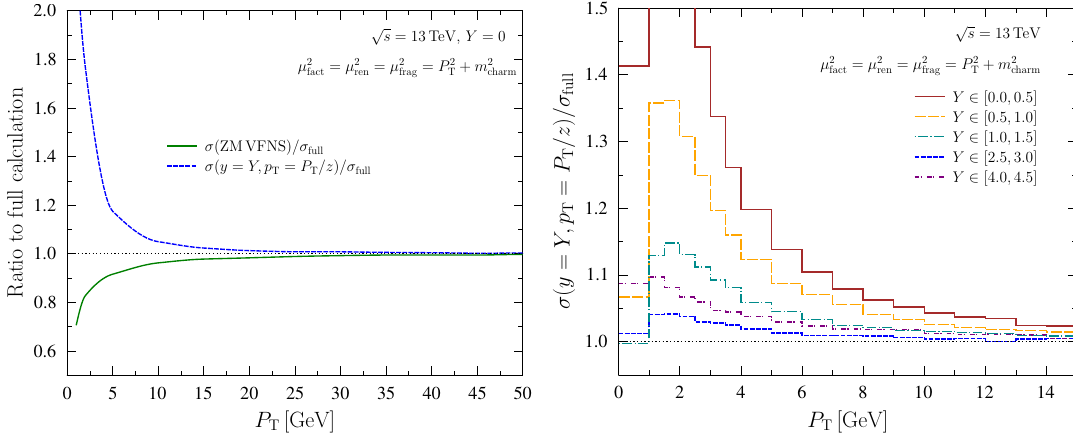
Figure 3 . Left-hand panel: a calculation at Y = 0 taking m = 0 in matrix elements (green curve), and the calculation ignoring the mass dependencies in the fragmentation variable z (blue dashed curve). In both cases, the results are normalized to the full calculation. Right-hand panel: relative e(cid:11)ect also at Y > 0 when ignoring the mass dependencies in the fragmentation variable z . shown in the right-hand panel would begin to dominate at higher P (cid:12)gure 2. As already mentioned in section 1, it was exactly this property that was